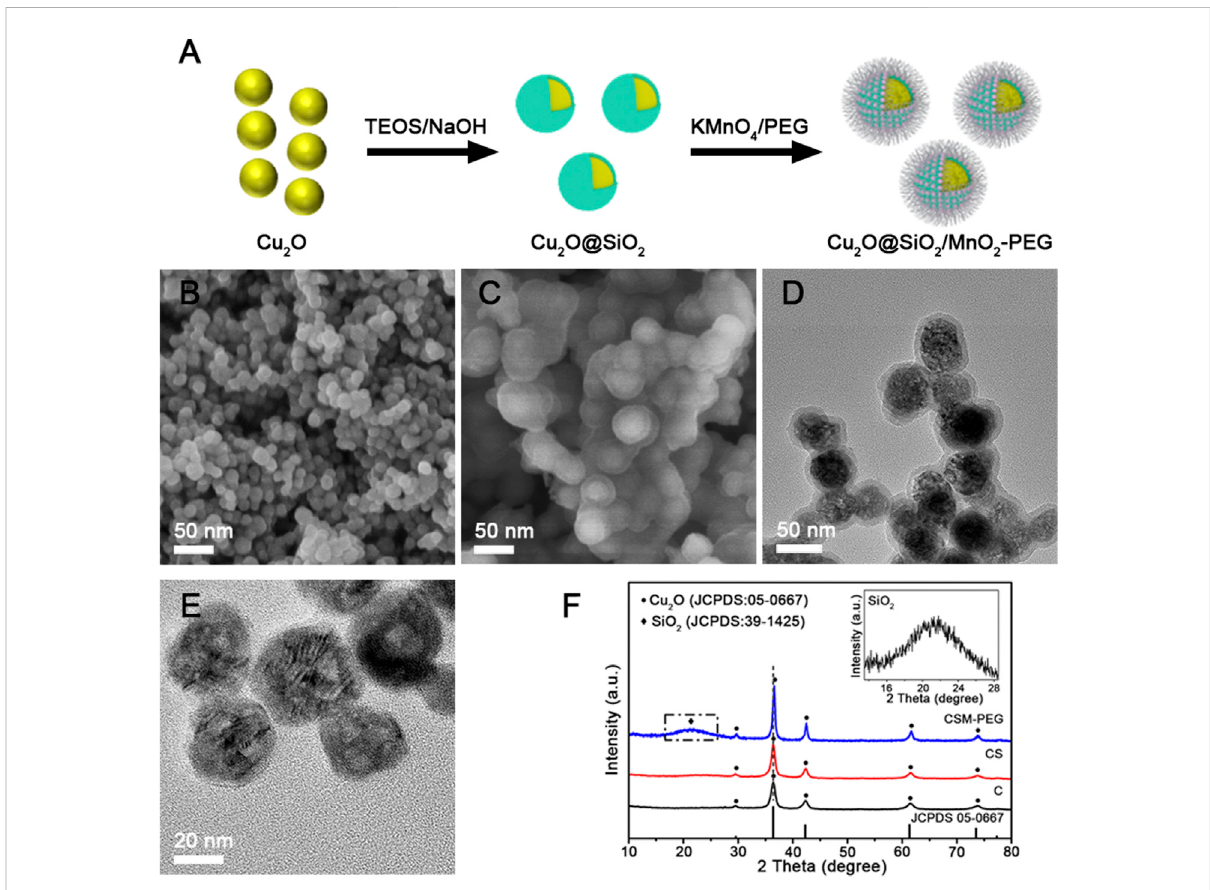
FIGURE 1 (A) The synthesis process of Cu 2 O@SiO 2 /MnO 2 − PEG. (B,C) SEM and TEM images of Cu 2 O. (D,E) SEM and TEM images of Cu 2 O@SiO 2 /